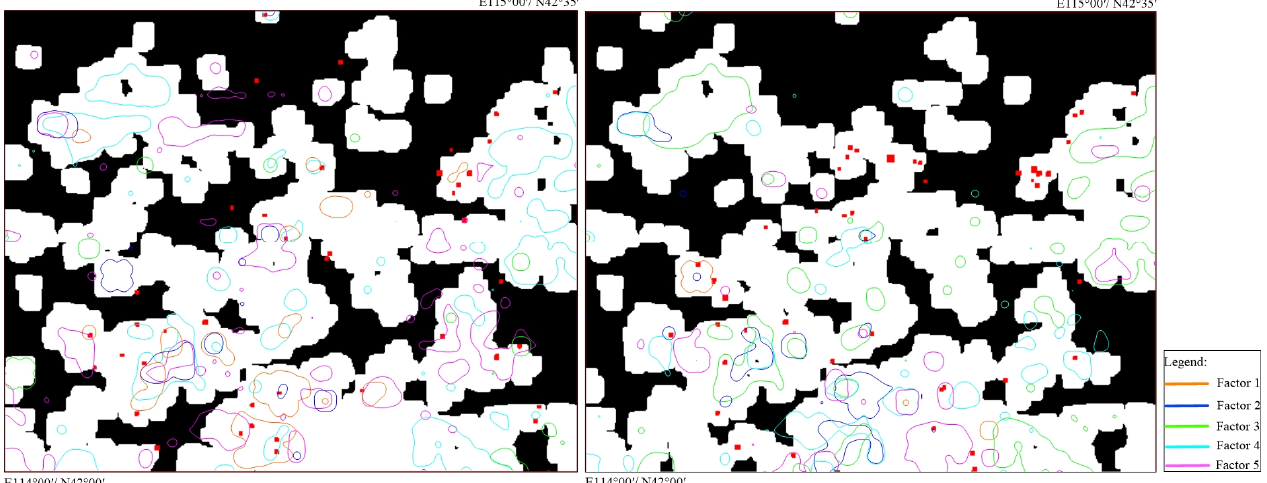
Figure 14. The geochemical anomalous areas (white) delineated in Figure 13 with relevant factor-score anomalies (colored polygons) overlaid on them. (Left): the I-series elements. (Right) the S-series elements. Note that: the factor-score anomalies were obtained by setting the binarization threshold as mean + 1×standard deviation. Other legends in this figure are consistent with those in Figures 9 and 10.